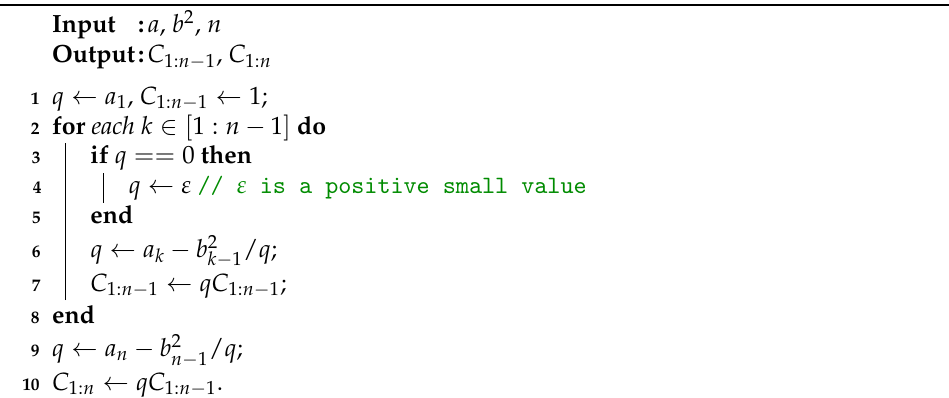
Algorithm 2: Computing ST